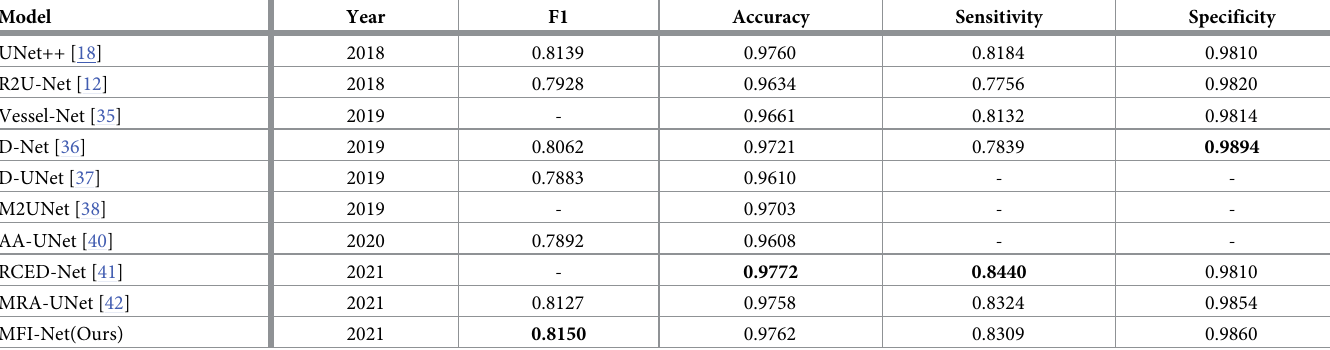
Table 4. Segmentation results of different models on the CHASE_DB1 dataset.